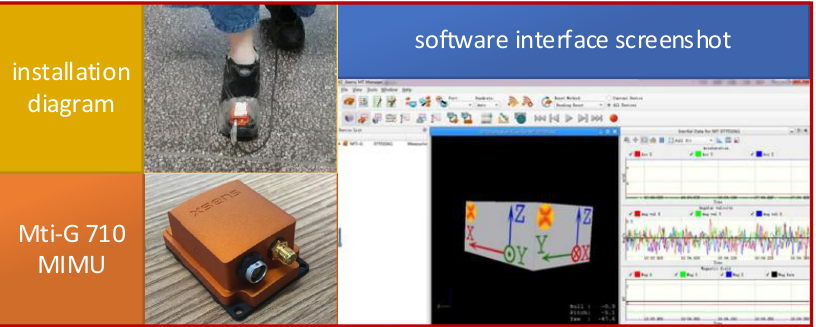
Figure 8. Device diagram for pedestrian-positioning test.